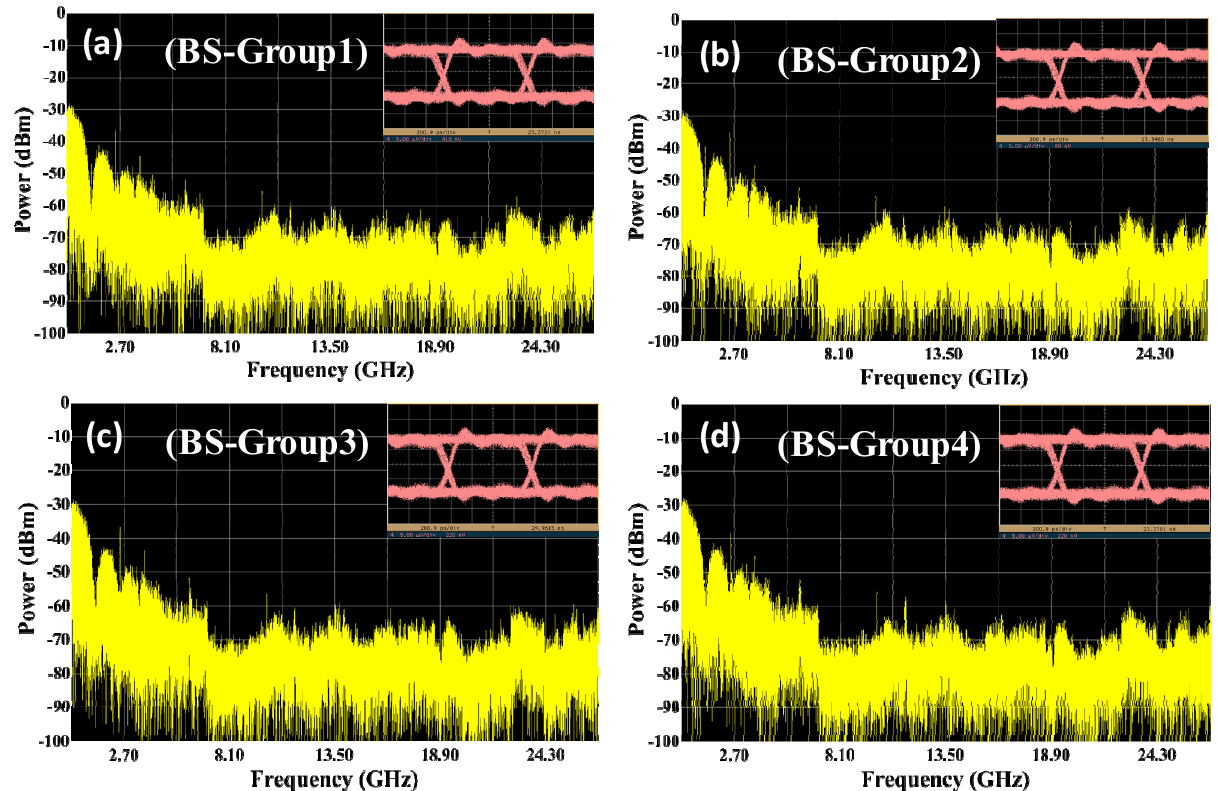
Figure 4. Electro-spectrum and eye diagram of frequency down-converted downlink RoF signals received by ( a ) BS-Group1, ( b ) BS-Group2, ( c ) BS-Group3 and ( d ) BS-Group4.